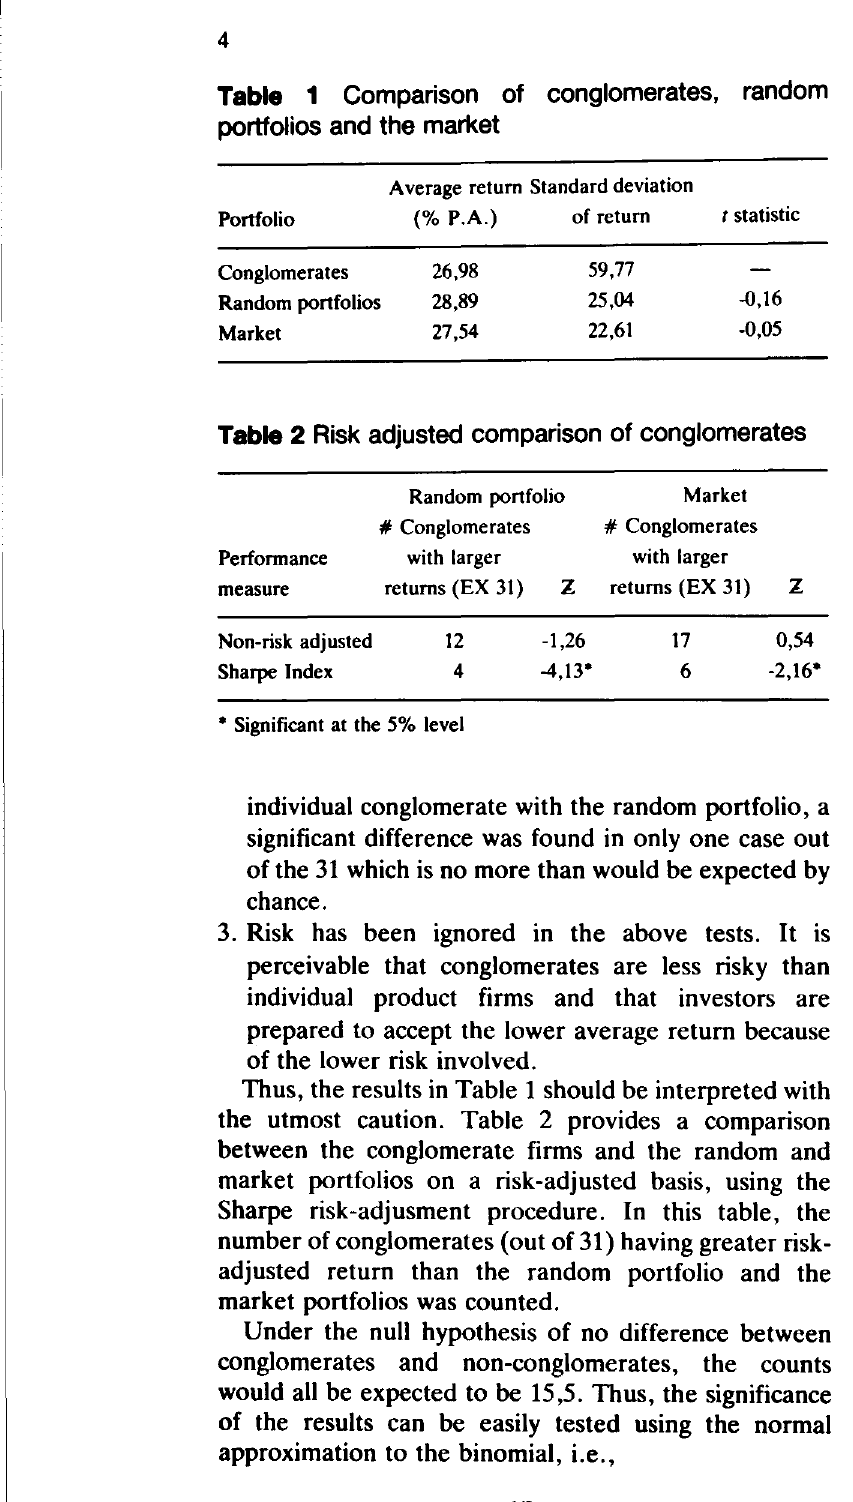
Table 1 Comparison of